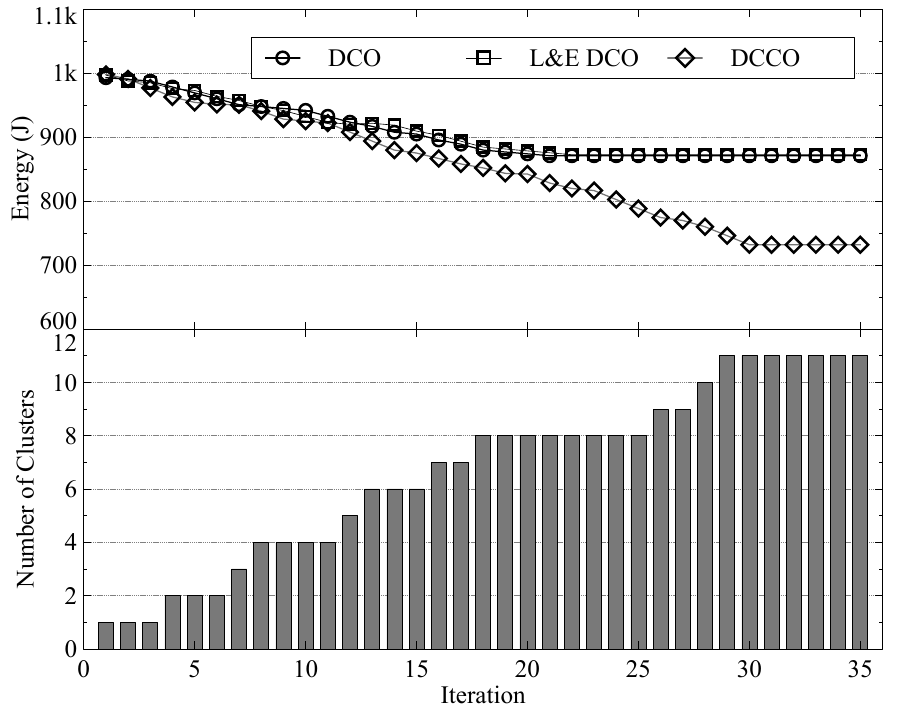
Figure 9. The convergence performance with 70